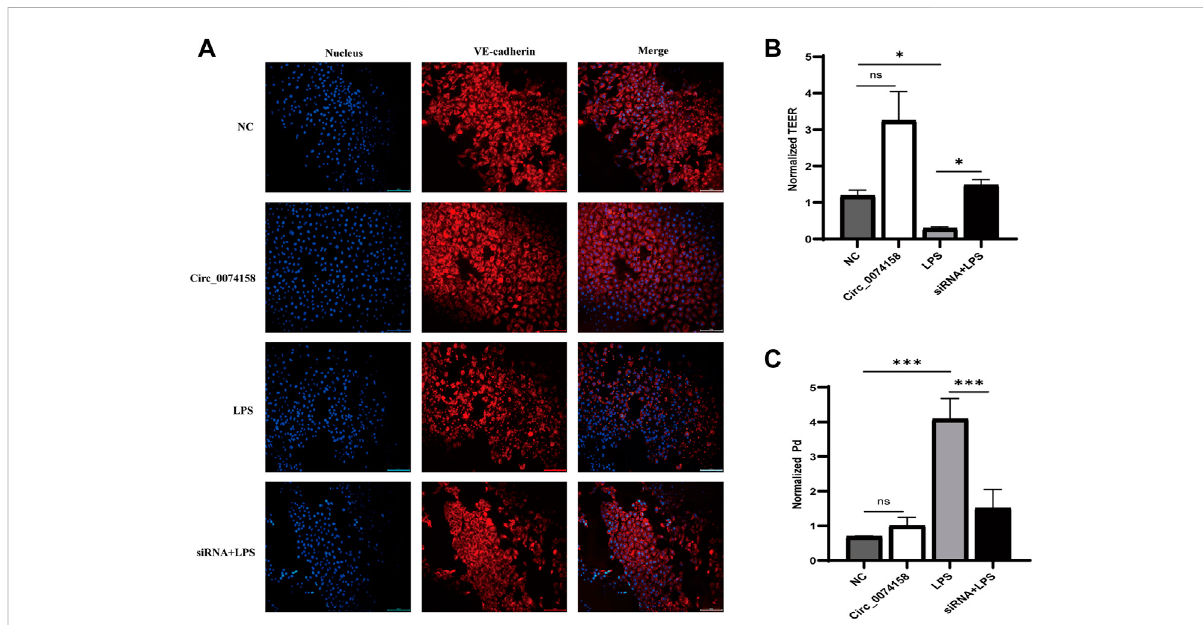
FIGURE 5 Hsa_circ_0074158 regulates the endothelial barrier function in sepsis. (A) The silencing of hsa_circ_0074158 enhanced the expression of VE- cadherin, which was down-regulated in LPS-induced sepsis. Bar = 100 µm. (B) The endothelial permeability was measured by TEER assay and showed. (C) The endothelial permeability was determined using the FITC-dextran assay and showed. * p < 0.05, ** p < 0.01, *** p < 0.001. NC: Negative control groups. LPS: LPS groups. Circ_0074158: Circ_0074158 groups. siRNA + LPS: si-circ_0074158 + LPS